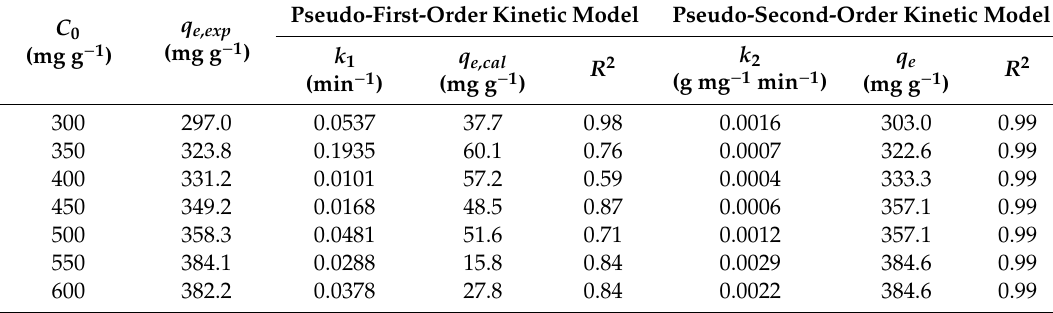
Figure 9. Plots of ( a ) pseudo-first-order, and ( b ) pseudo-second-order for the adsorption of MB onto BSNC-800-4 at different initial MB concentrations at 298 K. Table 3. Kinetic model parameters for the adsorption of MB onto BSNC-800-4 at di ff erent initial MB concentrations at 298